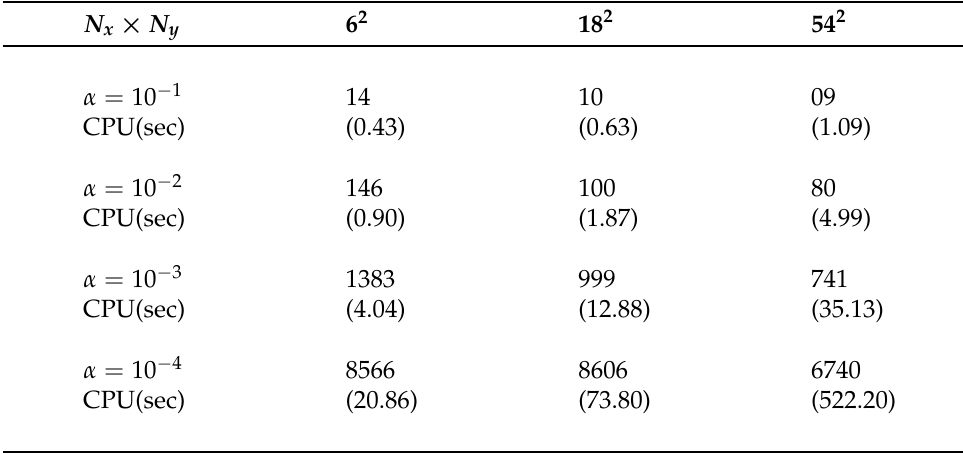
Table 2. Iteration counts and CPU time for stochastic Stokes control